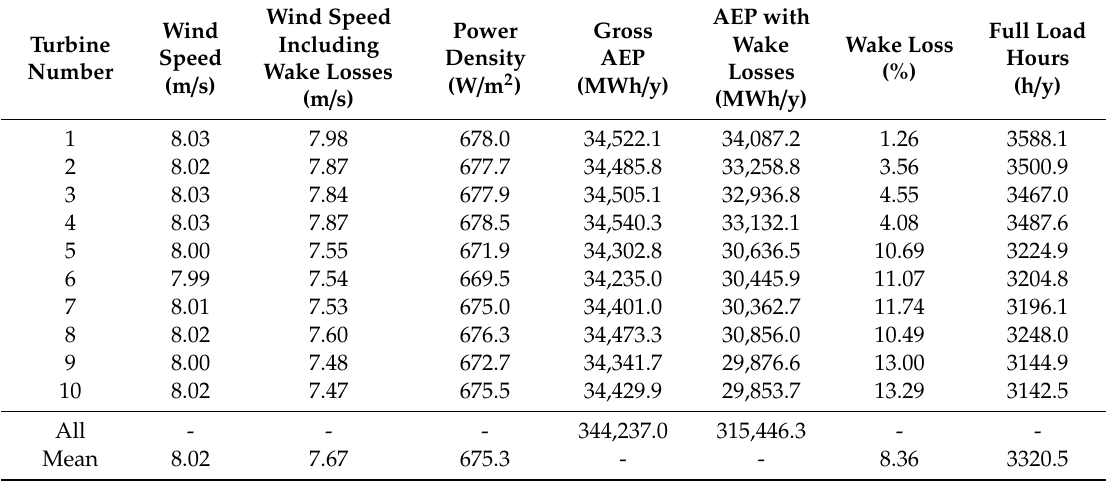
Table 8. Estimated power generation by the wind farm according to WindSim and MCP with data from the floating LiDAR device and MERRA. The assigned turbine numbers are the same as in Figure